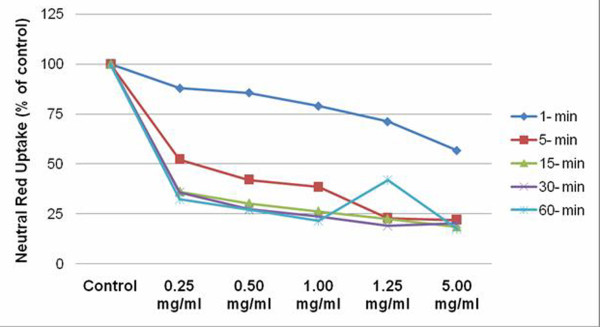
Cell viability evaluated by Neutral Red assay, demonstrates a dose and time dependent decrease in cell viability following ICG exposure. Data expressed as percent of control.